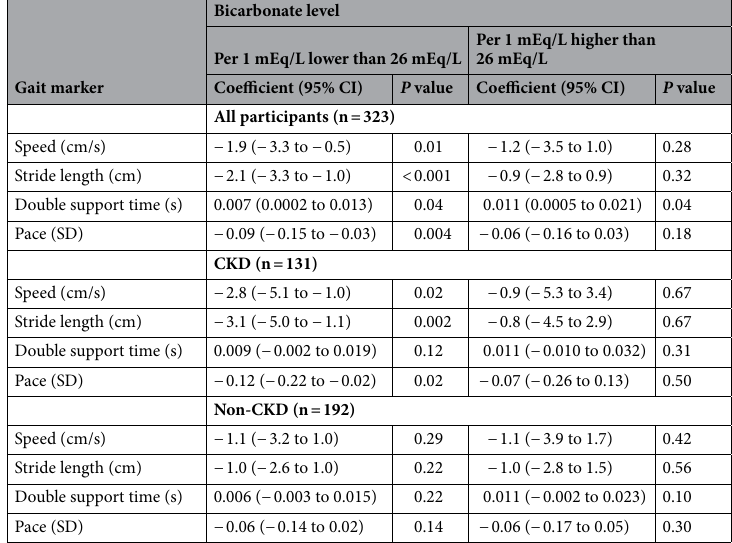
Table 4. Associations of continuous serum bicarbonate levels with gait markers using linear splines. CI confidence interval, CKD chronic kidney disease, SD standard deviation. Multivariable linear spline regression adjusting for age, sex, race, education, smoking status, body mass index (BMI), number of comorbidities, number of medications, diuretic use, diagnosis of neuropathy, cardiovascular disease, hypertension, diabetes, emphysema or chronic obstructive pulmonary disease (COPD), blood urea nitrogen (BUN), and estimated glomerular filtration rate (eGFR) was performed. The knot was placed at serum bicarbonate 26 mEq/L. CKD was defined as eGFR < 60 mL/min per 1.73 m 2 . P values for interaction between continuous serum bicarbonate below 26 mEq/L and eGFR: gait speed ( P = 0.05), stride length ( P = 0.01), double support time ( P = 0.04), pace ( P = 0.02). P values for interaction between continuous serum bicarbonate above 26 mEq/L and eGFR: gait speed ( P = 0.52), stride length ( P = 0.59), double support time ( P = 0.28), pace ( P =